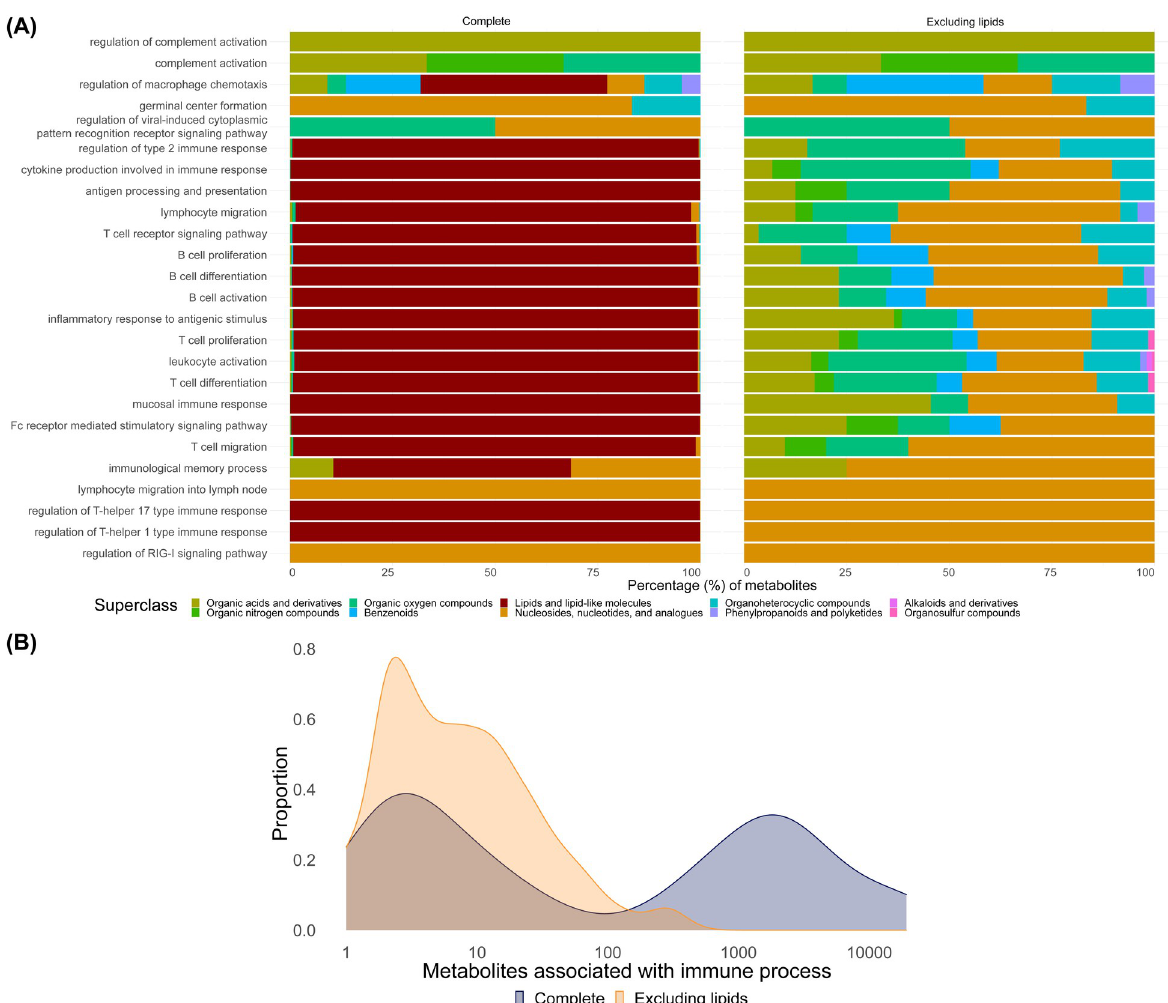
Fig 4. Overview of immune process and metabolite associations. (A) Distribution of the biochemical metabolite classes identified for common immune processes in the IMA classified according to the standard textbook Janeway’s Immunobiology, either including (left) or excluding (right) lipids. (B) Distribution of the number of metabolites associated with specific immune processes inferred from the IMA, using first-order inheritance, either for excluding lipids (orange) or including all metabolites including lipids